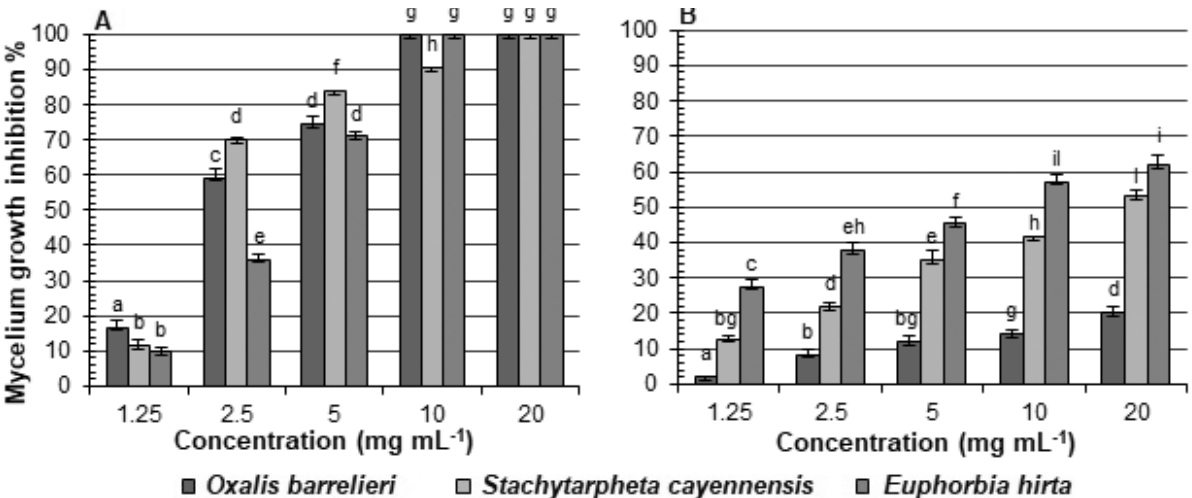
Figure 5. Mycelium growth inhibition of Alternaria solani at 1.25, 2.50, 5, 10 and 20 mg mL -1 concentrations of the ethanol extracts (A) and water extracts (B) from three plant species. Data are means ± standard deviation from three experiments, each with five replicates. At each concentration, the values accompanied by different letters are significantly different, according to ANOVA paired with Turkey’s tests ( P ≤